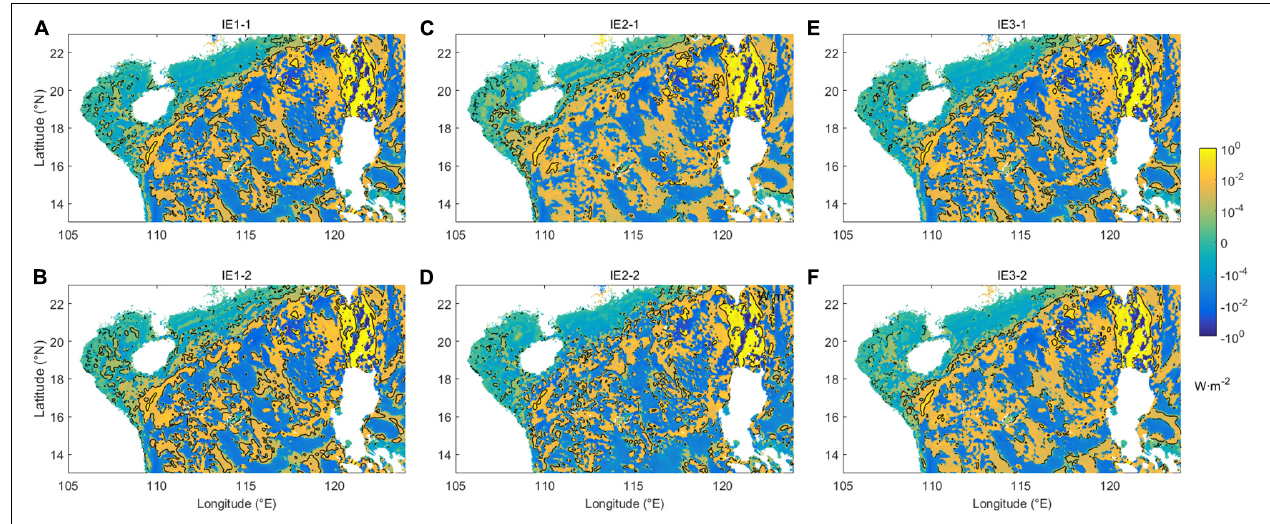
FIGURE 4 | Depth-integrated barotropic-to-baroclinic conversion rate (black lines indicate conversion of 0.5 Wm − 2 ) for (A,B) IE1, (C,D) IE2, and (E,F) IE3.